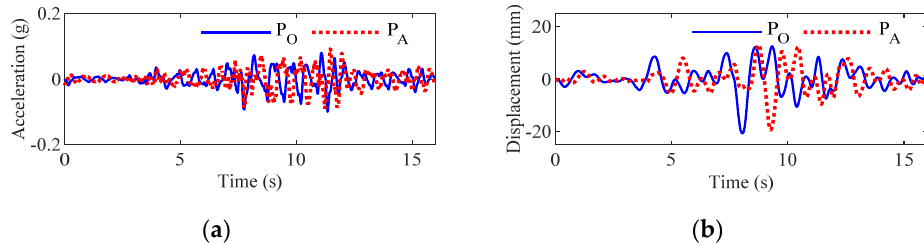
Figure 24. Accelerations and displacements in sample 3: ( a ) simulated accelerations and ( b ) its cor- responding displacements. corresponding